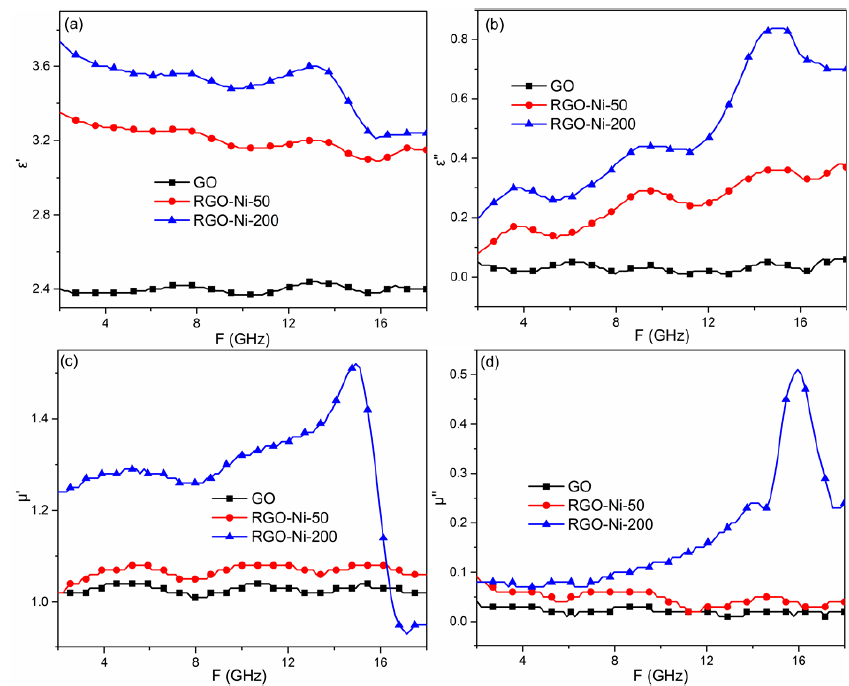
Figure 3. ( a , b ) Complex permittivity (ε′, ε′′) and ( c , d ) complex permeability (μ′, μ′′) spectra of